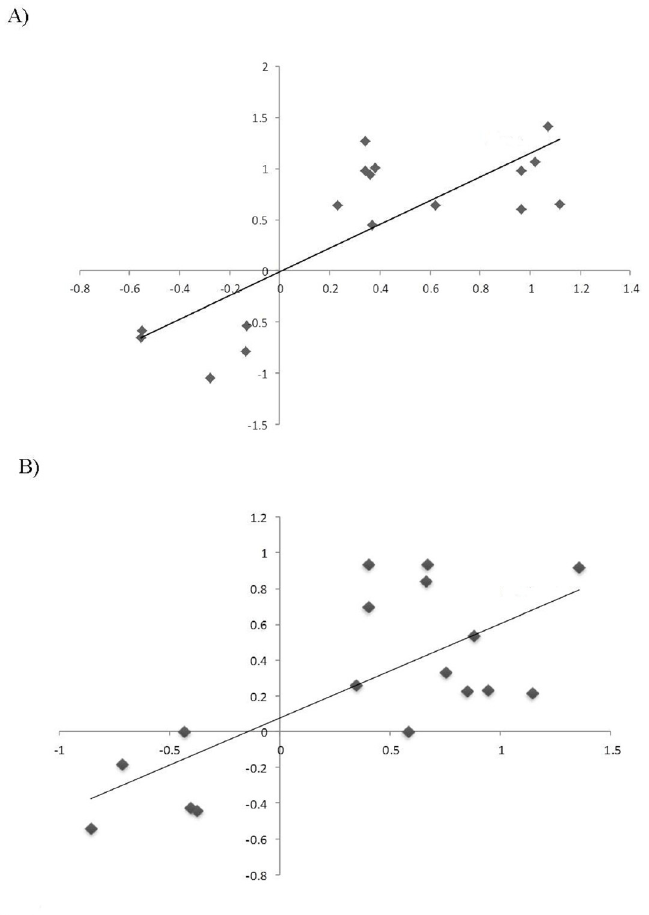
Fig 5. Correlation between RNA-Seq and RT-qPCR data. Twelve up-regulated and five down-regulated genes were selected for validation and a Pearson's correlation was calculated base on the expression values generated for each AtUCP1 OE line (P07 and